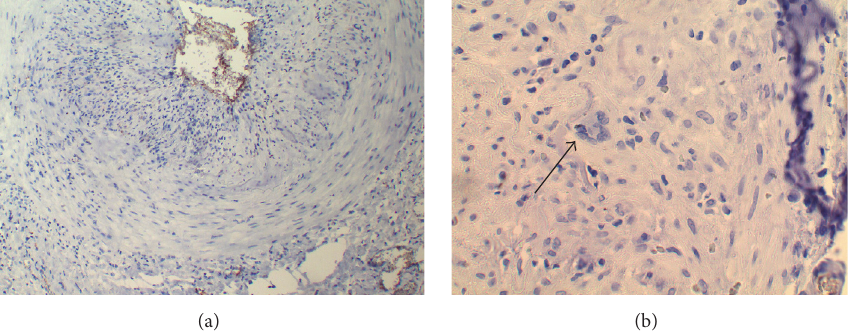
Figure 2: (a) Staining for AAT on temporal artery biopsy. (b) Temporal artery biopsy demonstrating GCA; arrow: giant